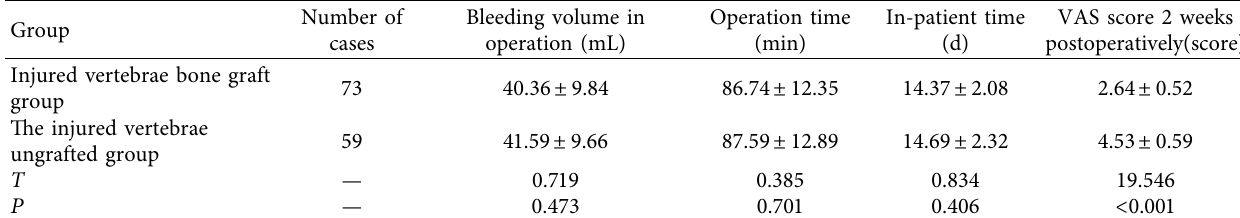
Table 2: Comparison of perioperative indicators between the two groups of patients ( X ± S ).